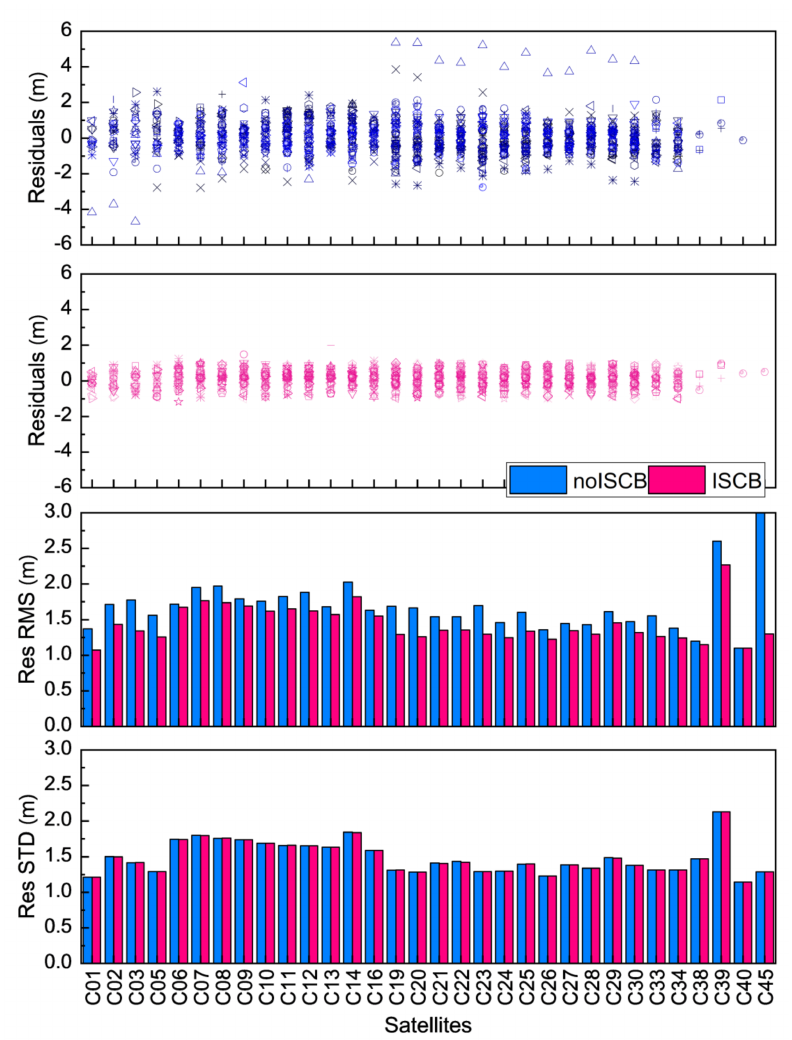
Figure 7. Comparison of the BDS, 2+3 pseudorange residuals before and after ISCB self, calibration. RMS, root mean